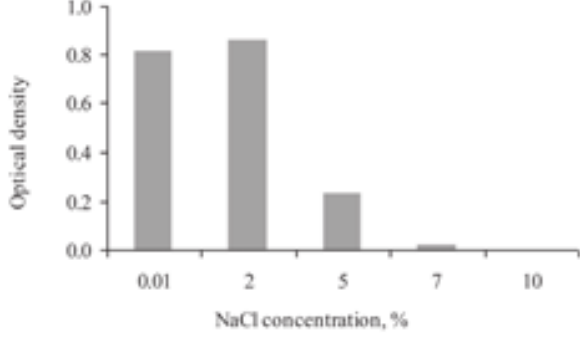
Fig. 1: The growth of isolated bacterium in liquid SLP medium supple- mented with increasing NaCl concentrations